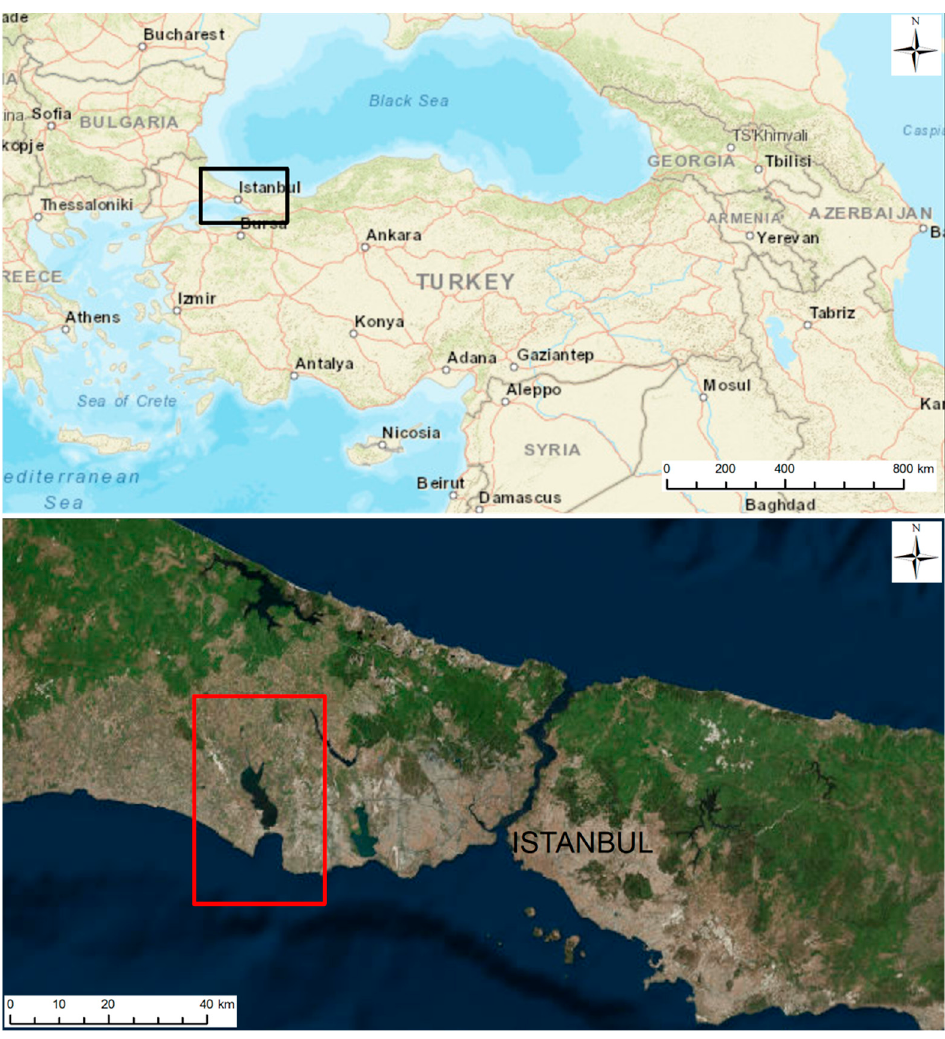
Figure 1. Study area.